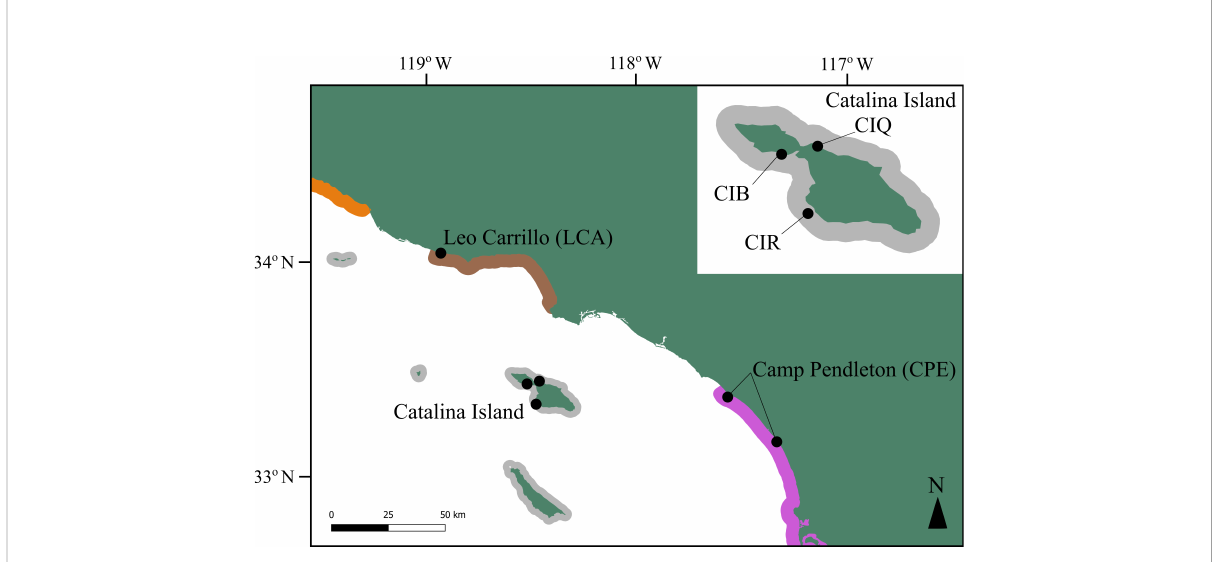
FIGURE 1 Map showing Macrocystis pyrifera resampled locations in the Southern California Bight. Colors represent three genetic coancestry groups described by Johansson et al. (2015), including one region of admixture (brown): Continental Santa Barbara (orange), Northern and Southern Channel Islands (gray) and Southern California/Baja California (purple) groups. The 2018 sample location for Camp Pendleton is located 30 km SE of the 2008 location. Note that giant kelp beds do not occur continuously along the colored